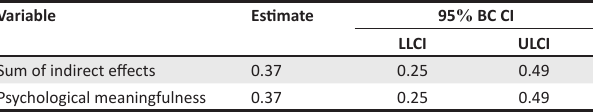
TABLE 4 : Indirect effects of psychological meaningfulness on commitment via work